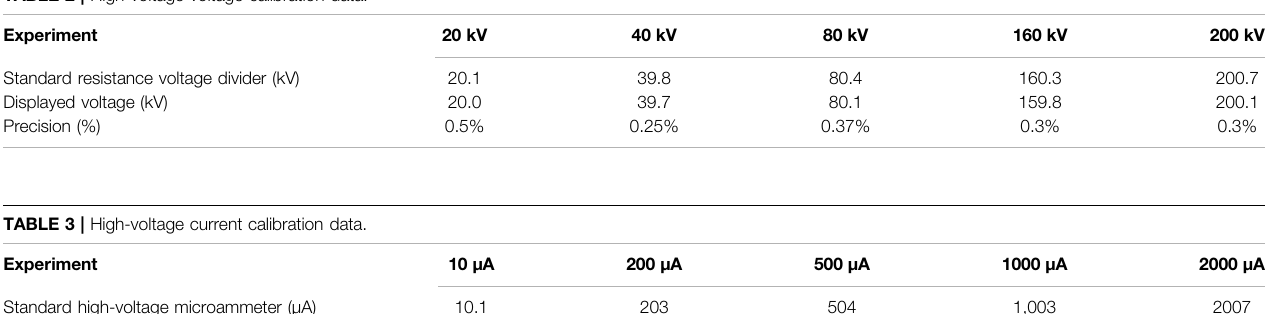
TABLE 2 | High-voltage voltage calibration data.